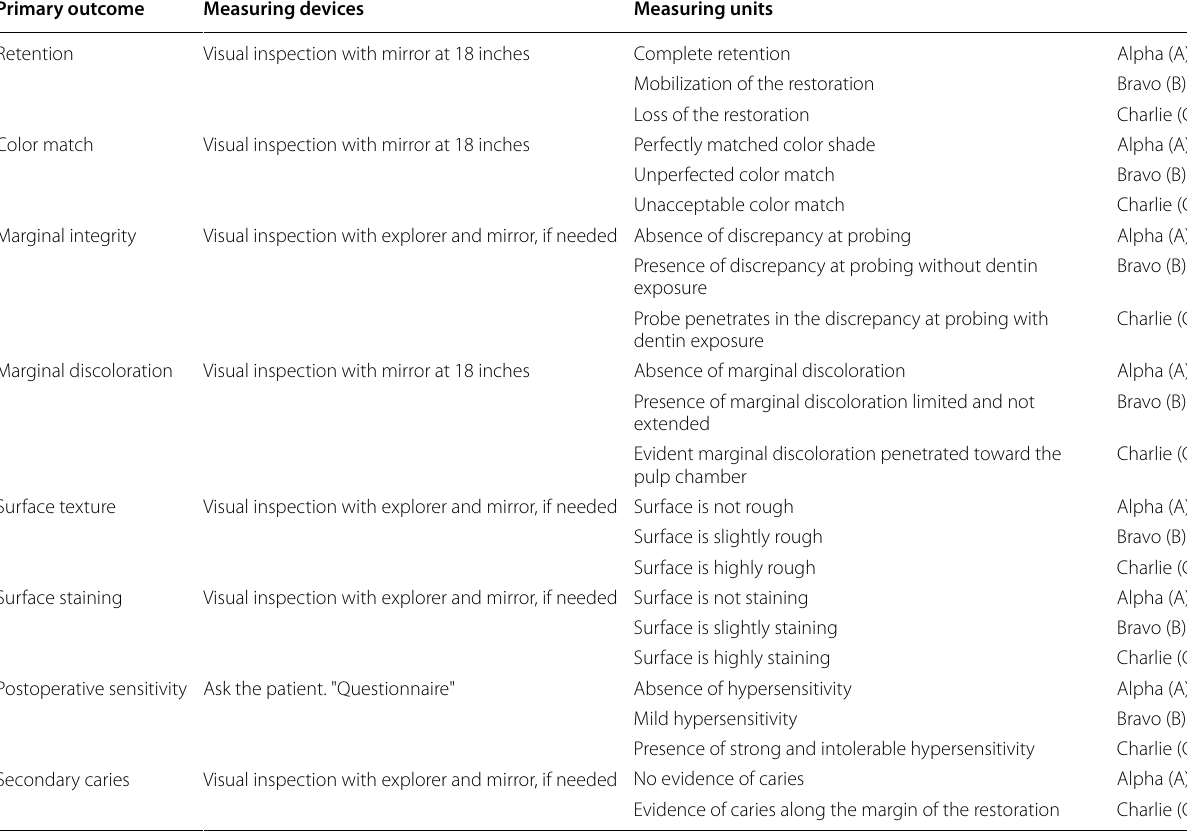
Table 2 Primary outcome, measuring devices and measuring units for in-vivo study using modified (USBHS)